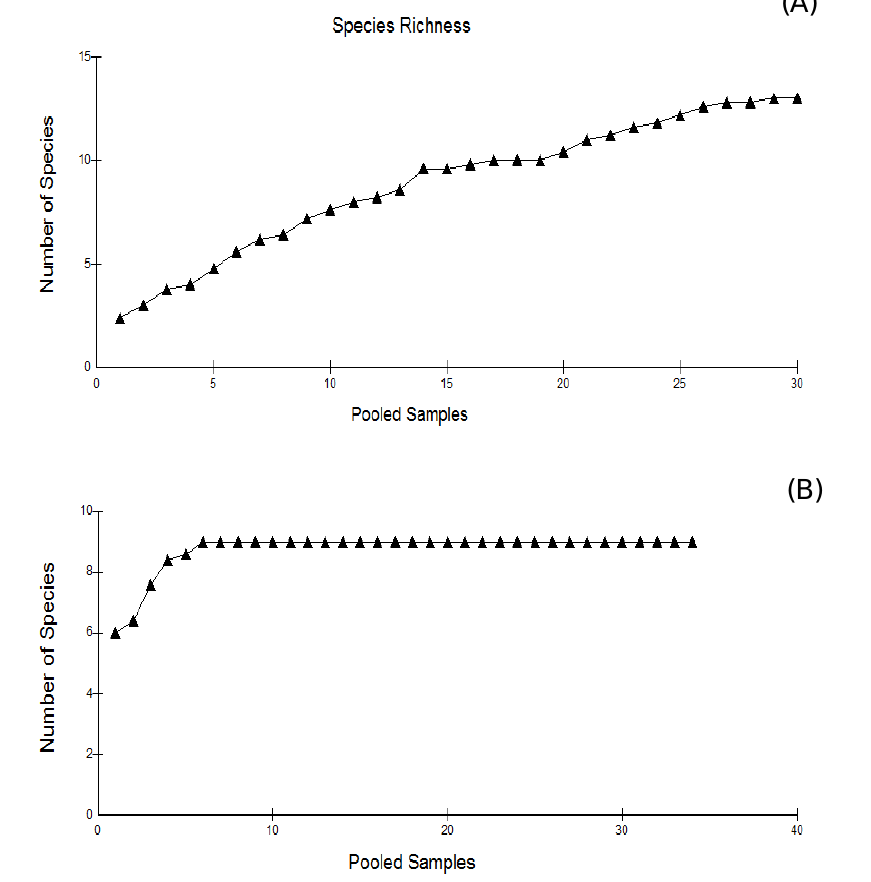
F IGURE 1. Species richness curve for bees visiting French bean flowers in ten farms neighbouring Mt Kenya forest in 2011 (A) and 2012